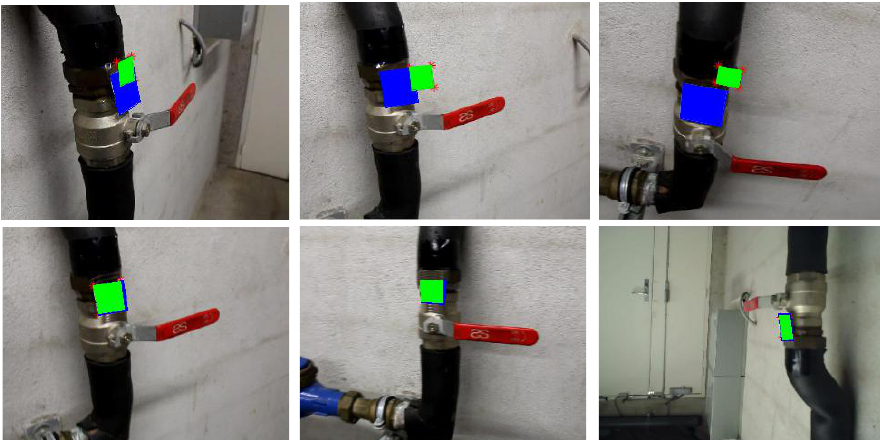
Figure 15. Comparison of marker reprojections (green) between the Industrial10-Traditional (upper) and Industrial10-WatchPose (lower) trained PoseNet. The ground truth is marked in